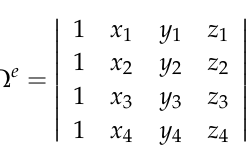
Figure 5. The hexagonal